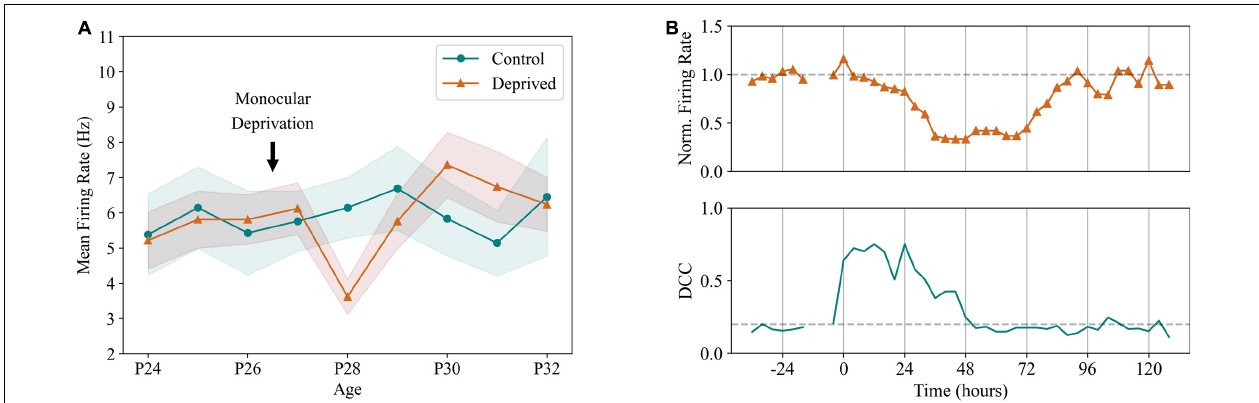
FIGURE 3 | Firing rate homeostasis in the cortex. (A) Homeostatic regulation of pyramidal neuron firing rates in a sensory deprivation protocol. In this experiment, unilateral deprivation of visual input was performed in rodents through lid suture, late at P26. Firing rates of the visual cortex in the deprived hemisphere show a significant reduction in the second day following suture, being recovered to pre-deprivation levels after 72 h, an effect not visible in the unaffected hemisphere. Adapted from Hengen et al. (2013). (B) After monocular deprivation, dynamics of the affected hemisphere show an immediate departure from criticality, quantified by increased distance from criticality coefficients (DCC). Criticality was recovered after 48 h through homeostatic plasticity, preceding the recovery of excitatory firing rates and indicating criticality as a setpoint for cortical dynamics. Adapted from Ma et al. (2019).